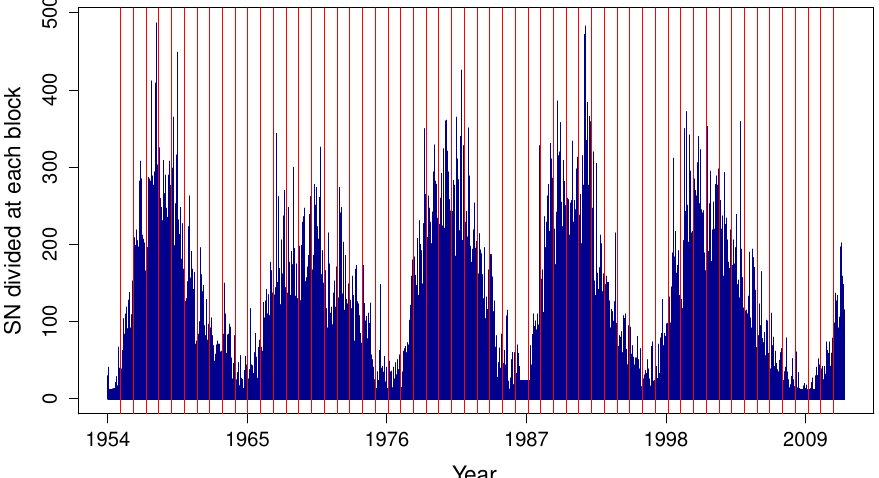
Figure 2. The SN divided into 58 blocks based on the BM